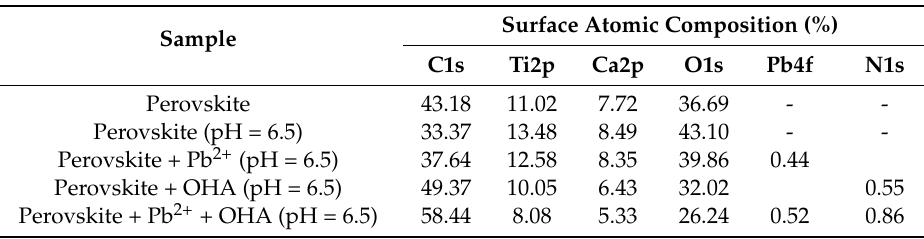
Table 2. Relative contents of elements on the perovskite